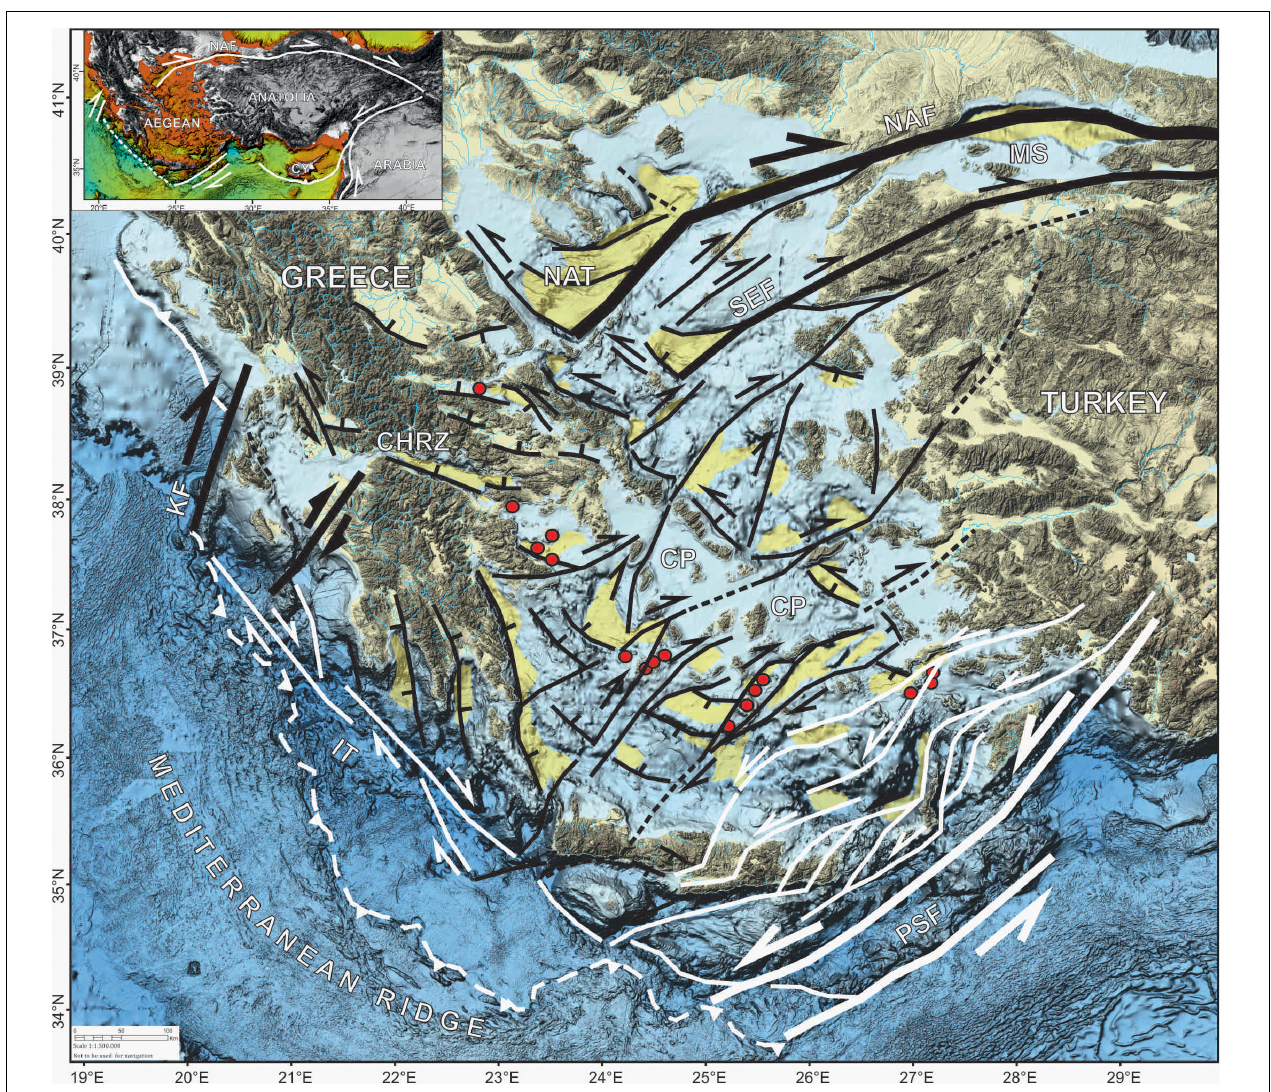
FIGURE 6 | Tectonic and kinematic map of the NAF and the Aegean region based on interpretations by Sakellariou and Tsampouraki-Kraounaki (2019). The NAF, the Skyros-Edremit Fault (SEF) and major dextral, NE-SW trending fault zones in the Aegean along with their conjugate faults are drawn in black. The Pliny and Strabo Fault zones (PSF) and the sinistral fault zones in the Southeast Aegean are drawn in white. Yellow: Plio-Quaternary basins. Red dots: volcanoes of the South Aegean Volcanic Arc. KF: Kephallinia Fault; CP: Cyclades Plateau; IT: Ionian Trench; MS: Marmara Sea.